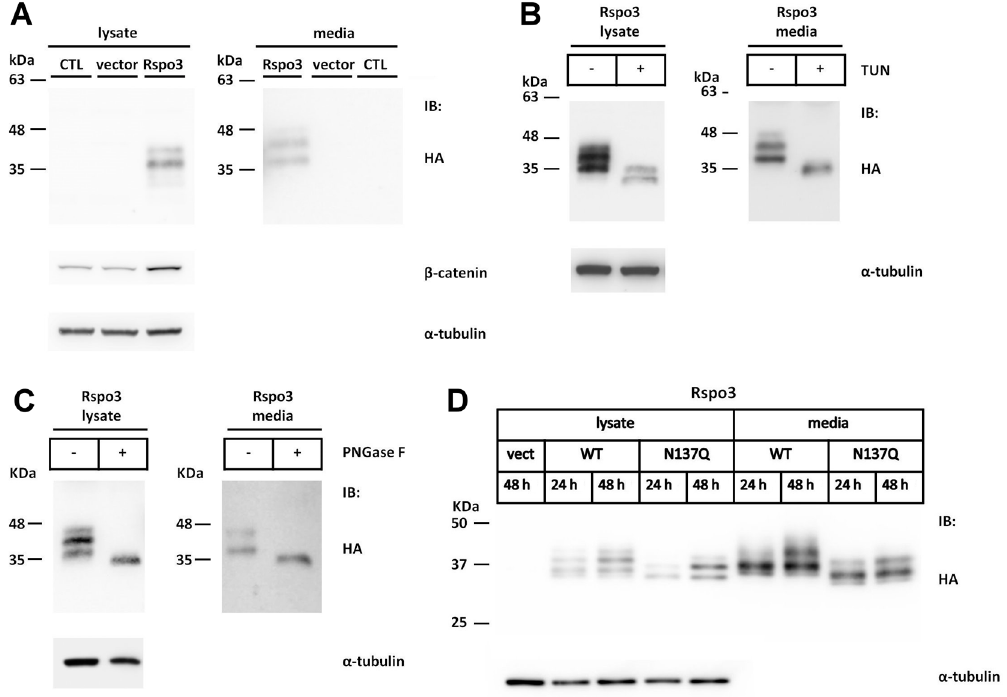
Figure 4. Cont. Figure 4.